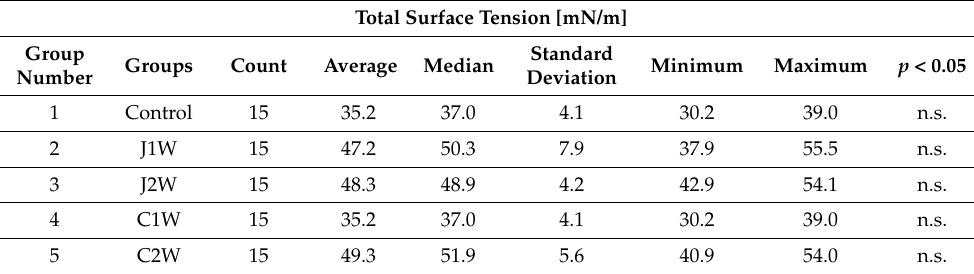
Table 7. Summary statistics of total surface tension, and results of Kruskal–Wallis multiple compari- son test. (Control—control group, J1W—juice one week, J2W—juice two weeks, C1W—Coca-Cola one week, C2W—Coca-Cola two weeks, and n.s.—no statistically significant